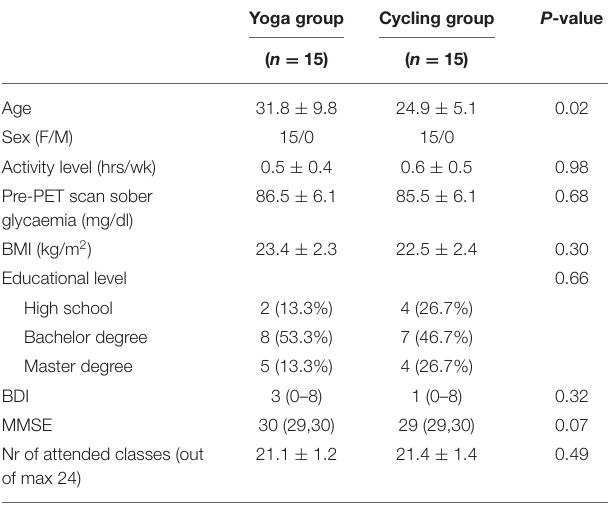
TABLE 1 | Subject demographics and study-related